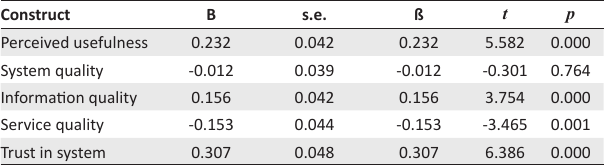
TABLE 5: Unstandardised and standardised regression coefficients for the factors.